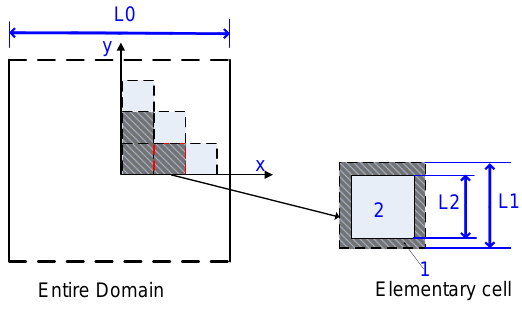
Figure 1: Periodic microstructure of composite with two materials 1 (matrix) and 2 (ferromagnetic grains).